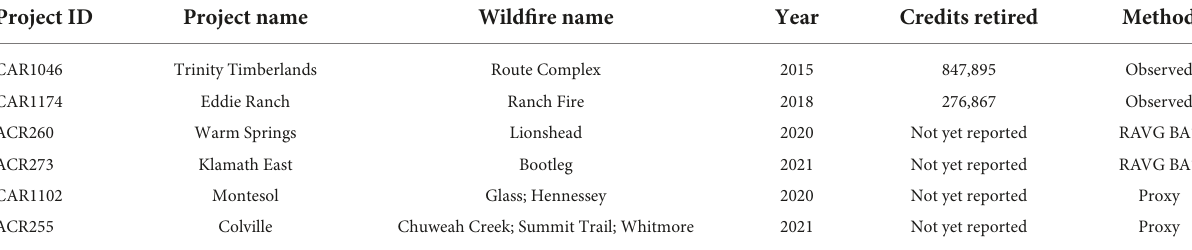
TABLE 1 List of forest offset projects affected by